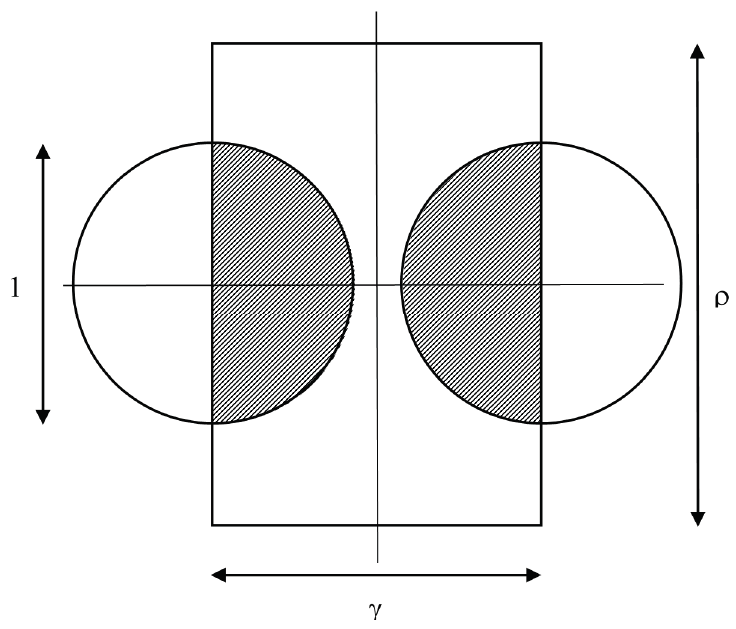
Figure 6. As for Figure 5, but with non-overlapping regions for successful